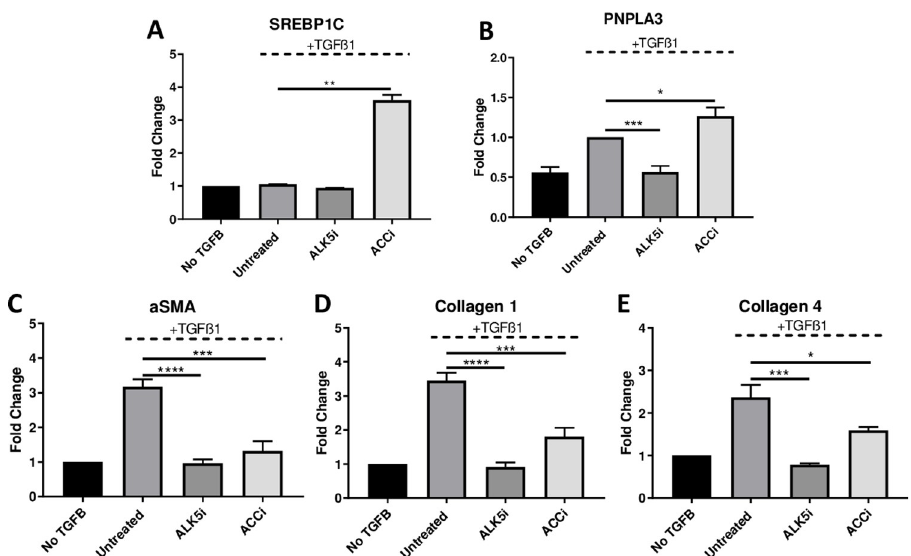
Fig 3. Upregulation of PNPLA3 in primary human HSCs by ACC inhibition. WT PNPLA3 HSCs donors (n = 3) were treated with a small molecule ACC inhibitor at 10uM for 16 hours in the presence or absence of 5 ng/ml TGF- β . A small molecule ALK5 inhibitor (1mM) was added simultaneously with the TGF- β to serve as a positive control for reversal of activation. Transcriptional regulation of SREBP1C (A) and PNPLA3 (B) was demonstrated by qPCR. mRNA expression of HSC activation markers α SMA (C), COL1A1 (D), COL1A4 (E) were also determined by qPCR. Values are mean +/- SEM; � p < 0.05 �� p < 0.01 ��� p < .001 by t-test vs untreated condition. n = 2–6.